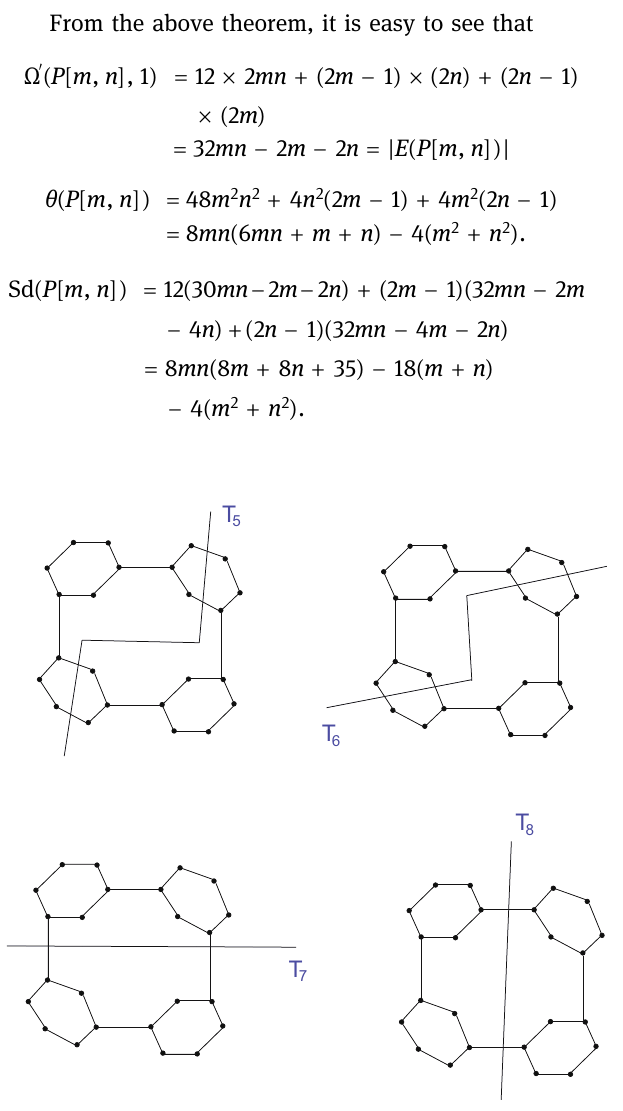
Figure 3: Quasi - orthogonal cuts of [ ] P m n , .